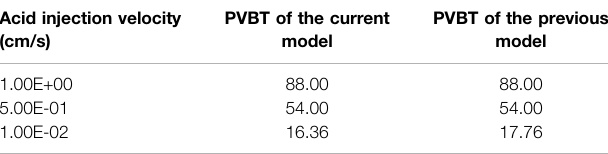
TABLE 1 | Comparison of PVBT values of different two-scale continuum models. Acid injection velocity